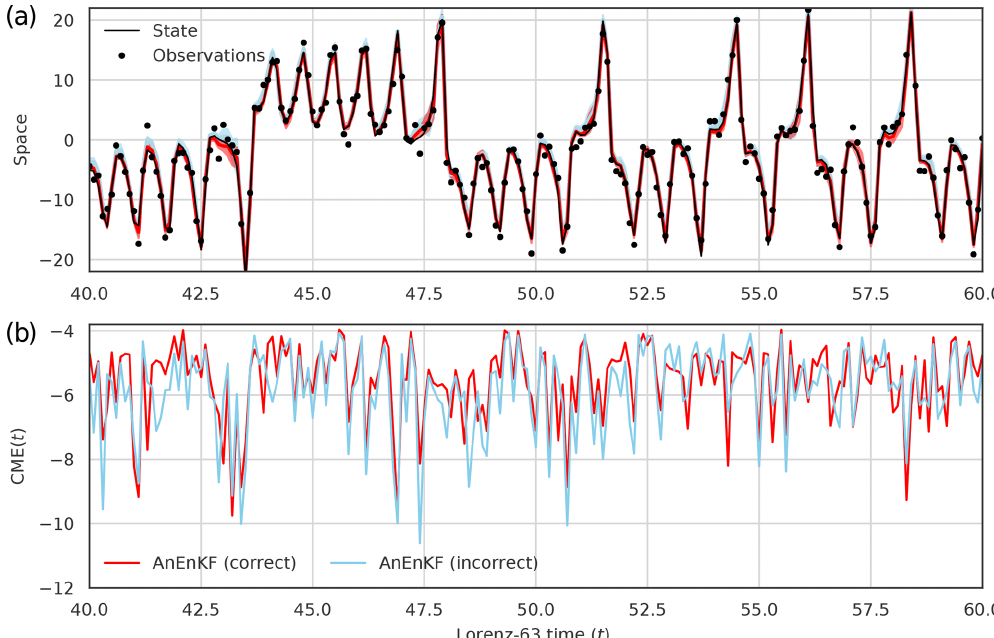
Figure 4. (a) Time series of the second component of the Lorenz-63 model with mean analysis and 95% prediction interval obtained using AnEnKF with the correct M ( 0 ) model (red) or using AnEnKF with the incorrect M ( 8 ) model (blue). (b) CME time series for the correct M ( 0 ) model and the incorrect M ( 8 ) model. N = 20 members are used and an inflation factor is applied in AnEnKF.